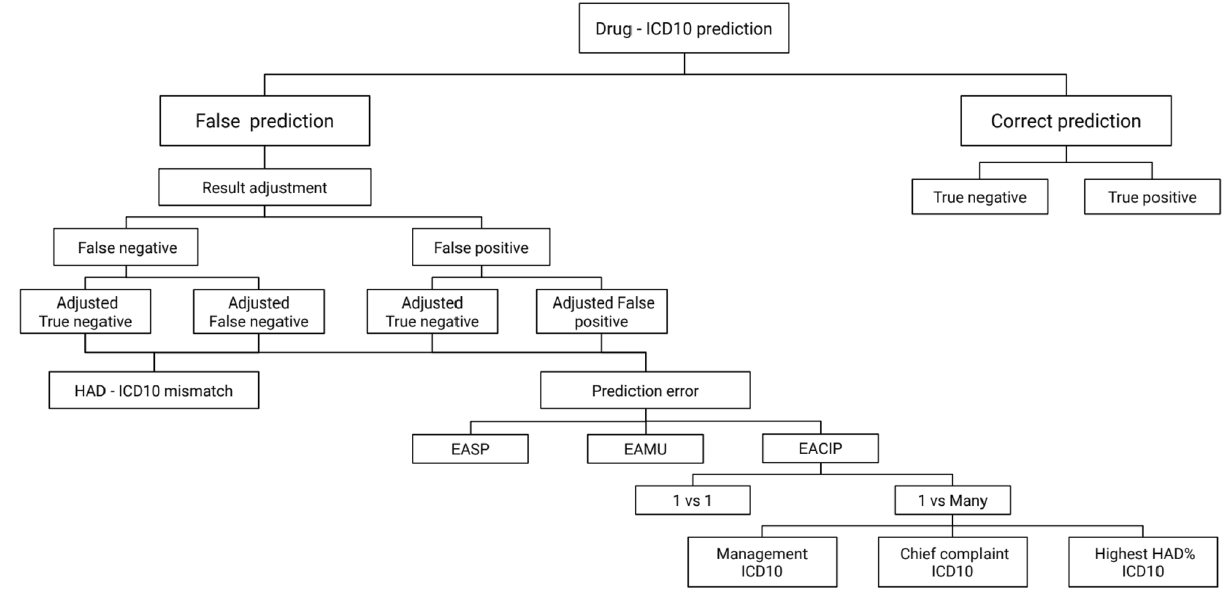
Figure 15. HAD prediction mind